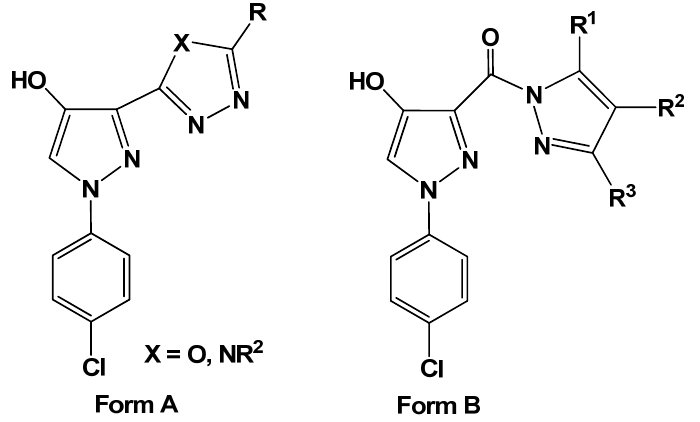
Figure 1. substituted pyrazoles with potential antitumor